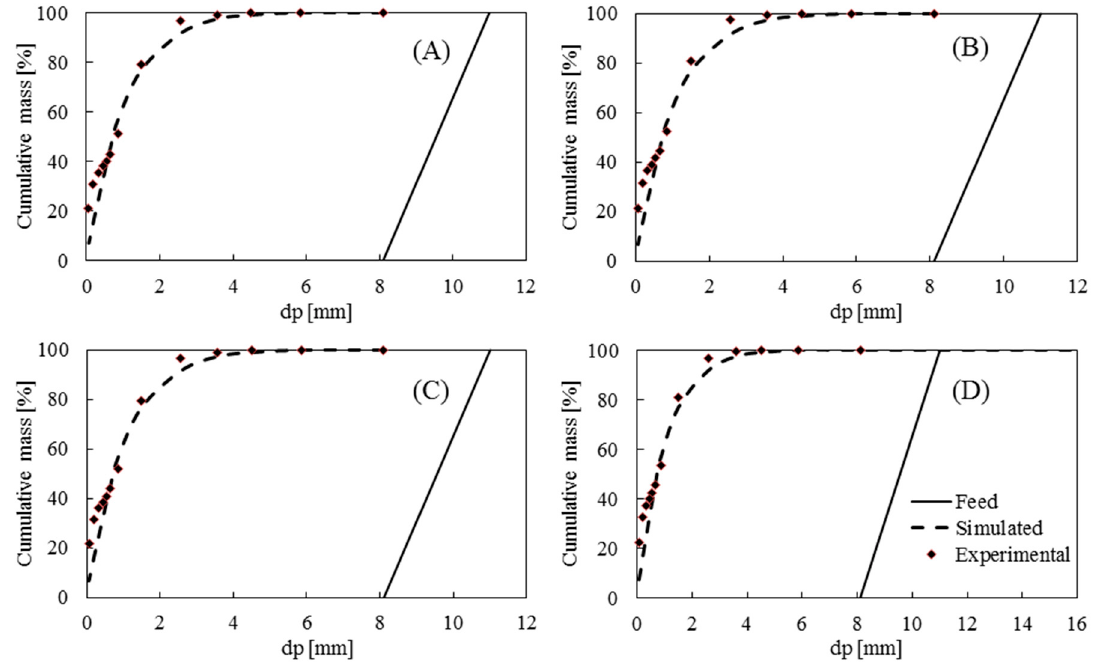
Figure 14. Feed, experimental and predicted curves in the altered granite showing the effect of varying roll speed. ( A ) PV-1; ( B ) PV-2; ( C ) PV-3 and ( D ) PV-4.